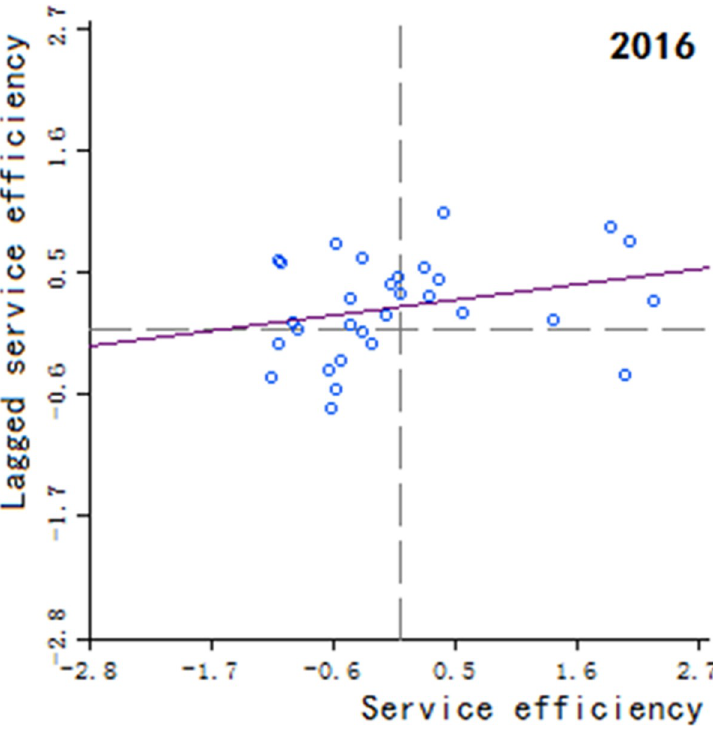
Fig 8. Scatter plot of China’s regional medical and health service level distribution from 2004 to 2018.